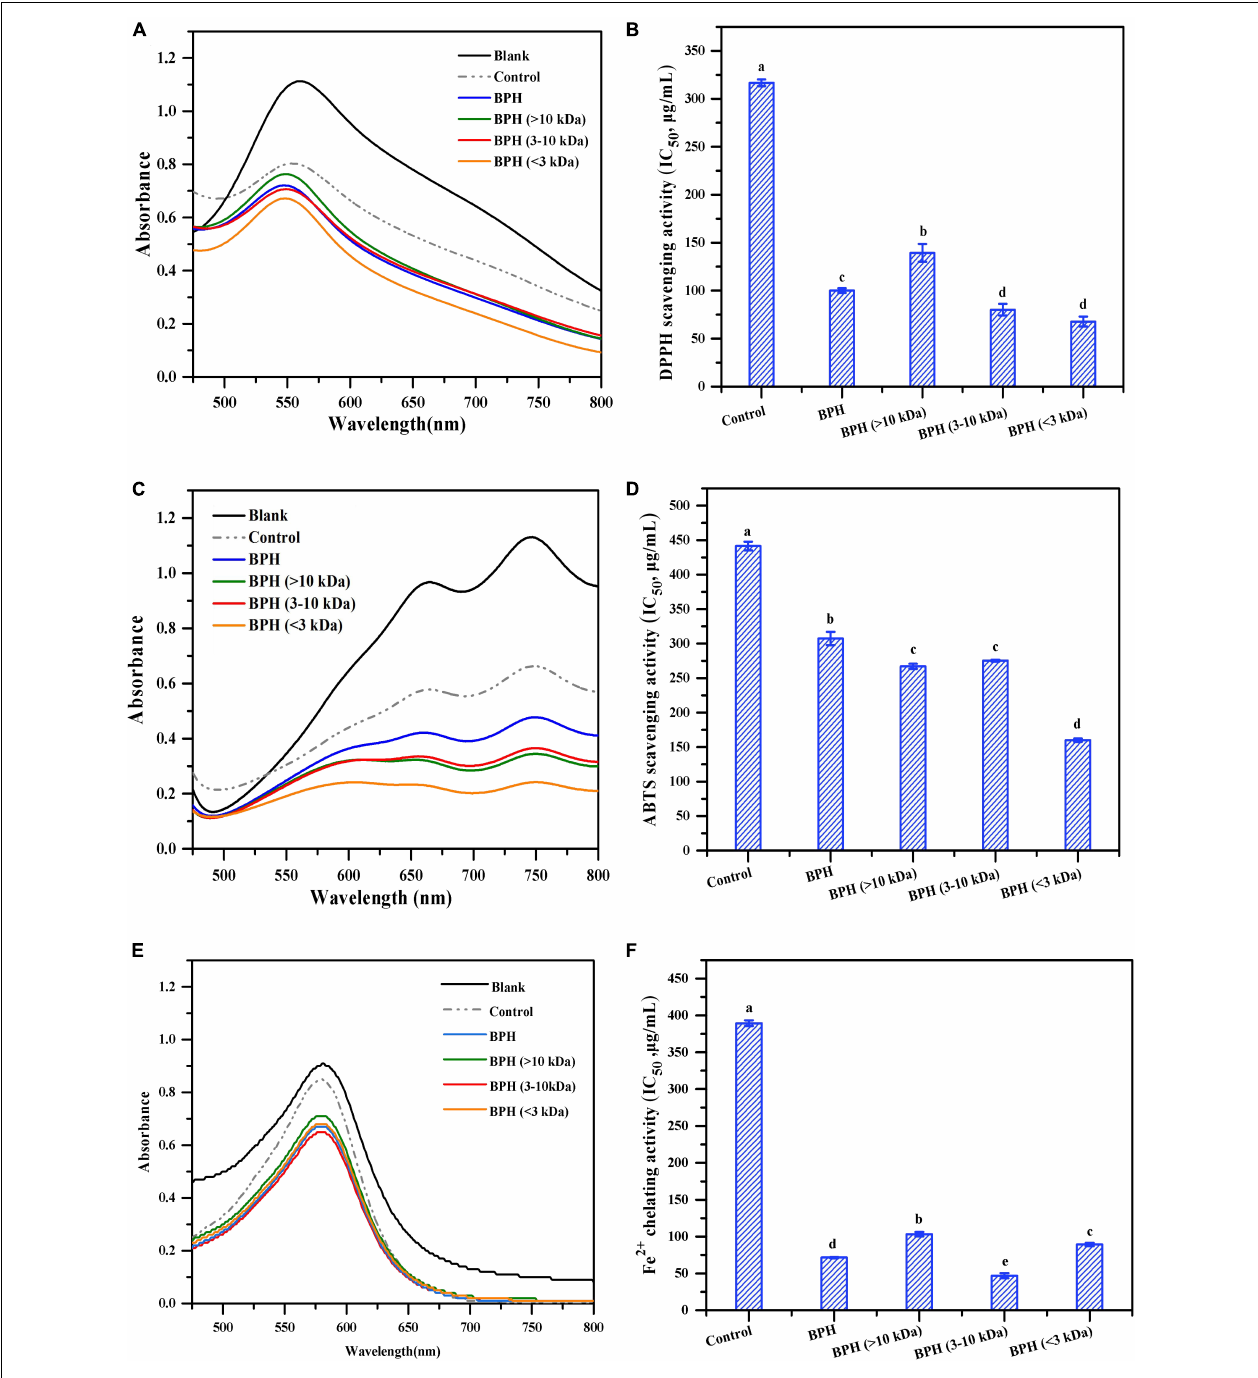
FIGURE 3 | DPPH radical scavenging activity (A,B) , ABTS radical scavenging activity (C,D) and Fe 2 + chelating activity (E,F) of BPH and its membrane fractions. Different letters indicate the significant difference ( P < 0.05).